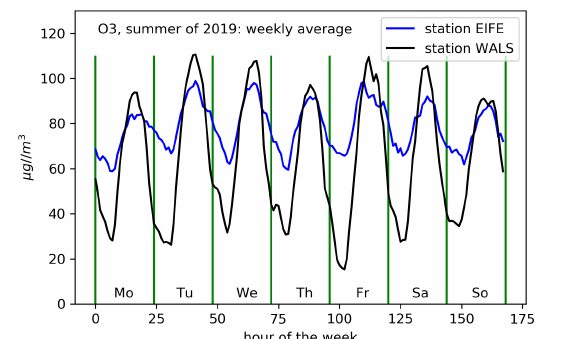
Figure 4. Weekly average values of O 3 (meteorological summer of the year 2019) for the urban station WALS (high volume of traffic) and the rural station EIFE (surrounded by vegetation, no buildings, scarcely any traffic).